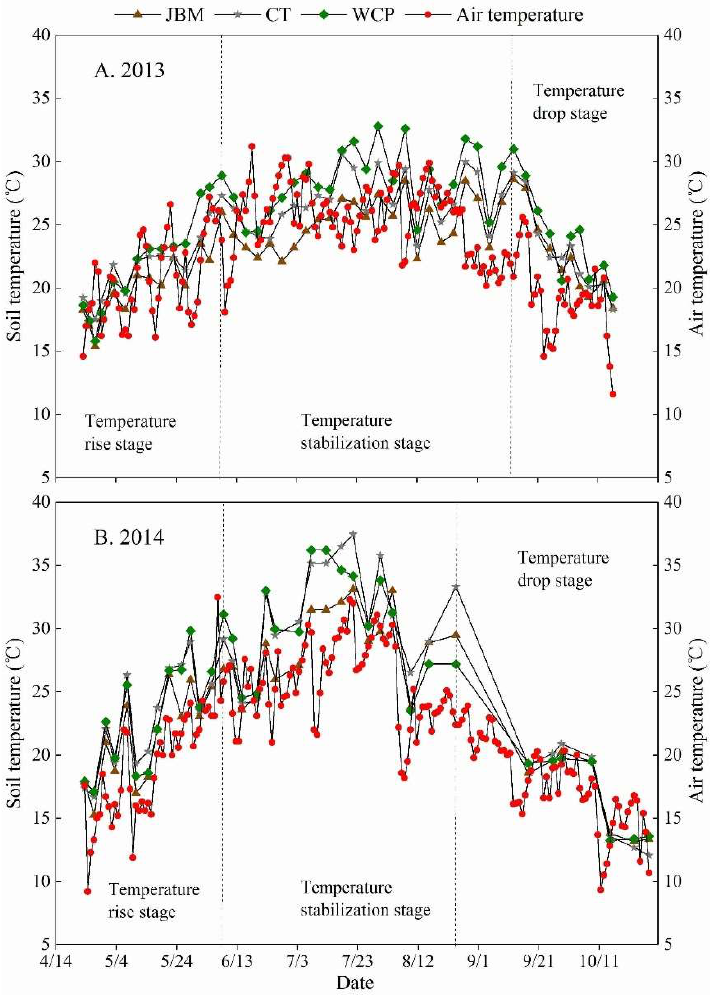
Figure 2. Dynamic changes in the 0–25 cm soil layer’s average soil temperature under different mulching measures over the ( A ) 2013 and ( B ) 2014 jujube growth seasons.